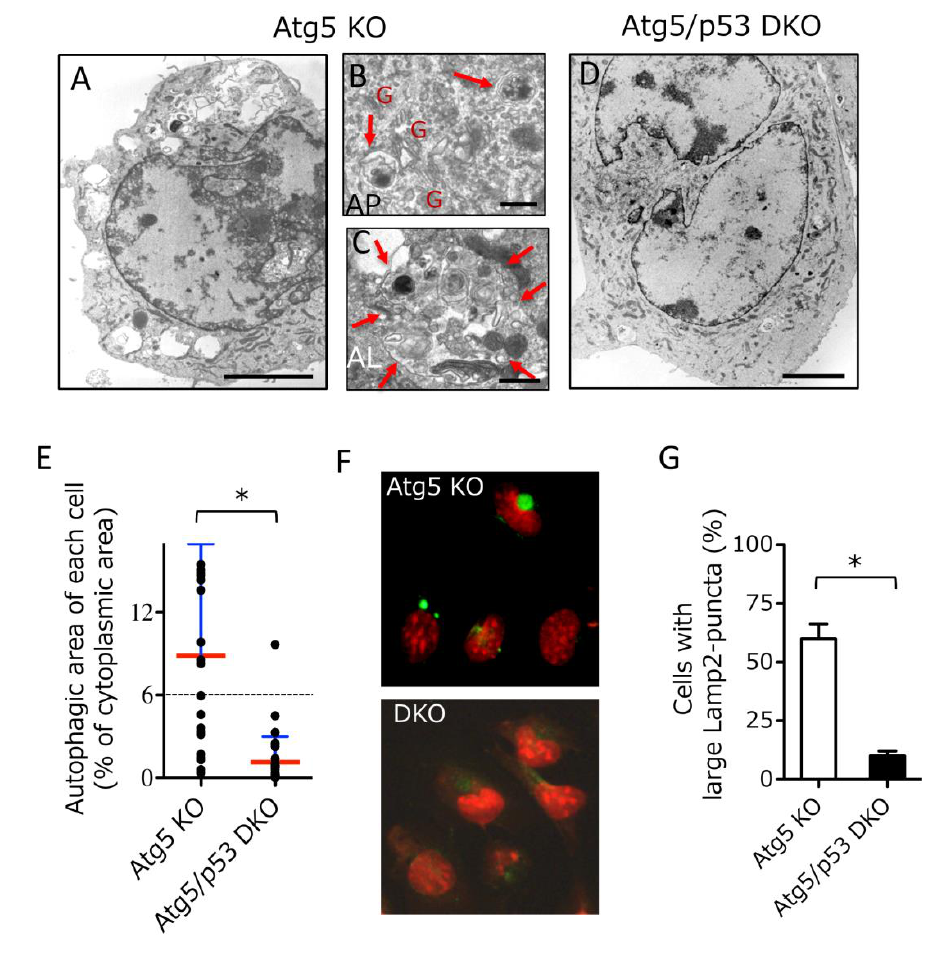
cells each). Red and blue lines indicate the mean and SD, respectively. The dotted line indicates the autophagic threshhold. *p < 0.05. (F) The indicated MEFs were treated with etoposide (10 µM) for examined for Lamp2 immu- nofluorescence (green) and nuclei were counterstained with propidium iodide